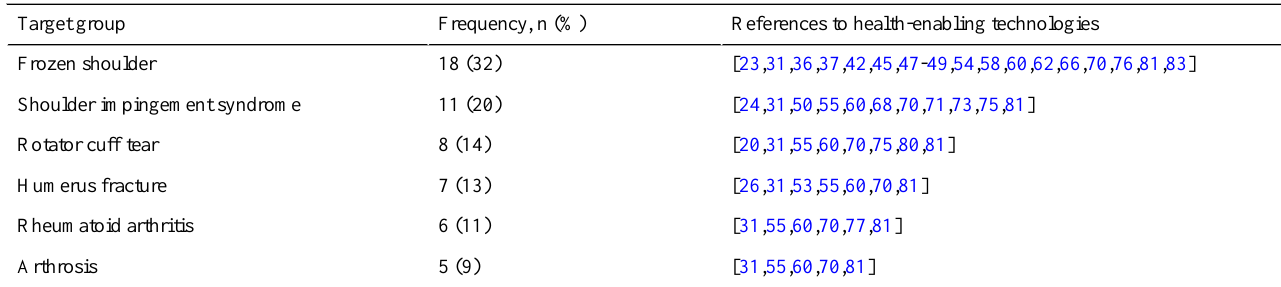
References to health-enabling technologiesFrequency, n (%)Target